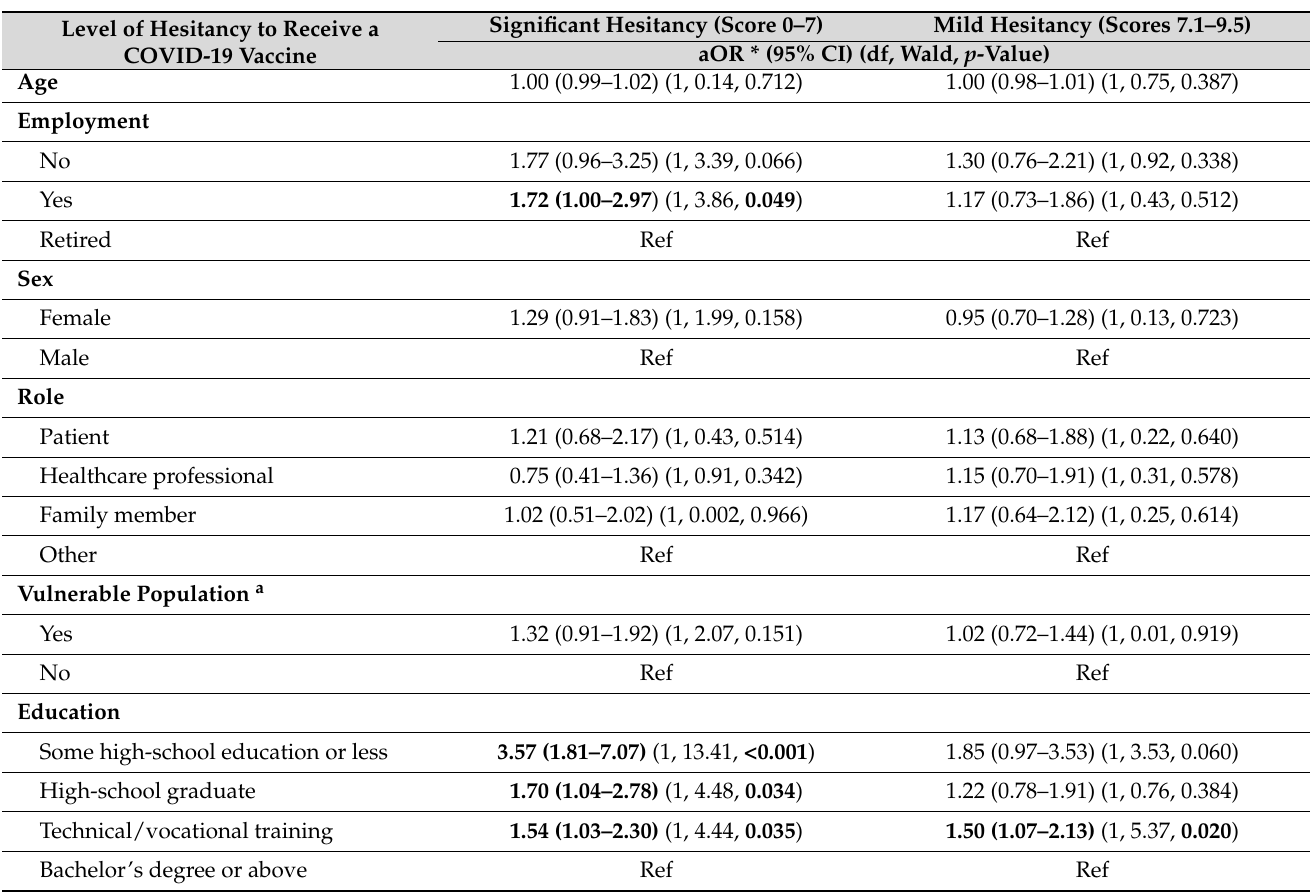
Table 3. Multivariate analysis of factors associated with vaccine hesitancy (non-hesitancy as refer- ence